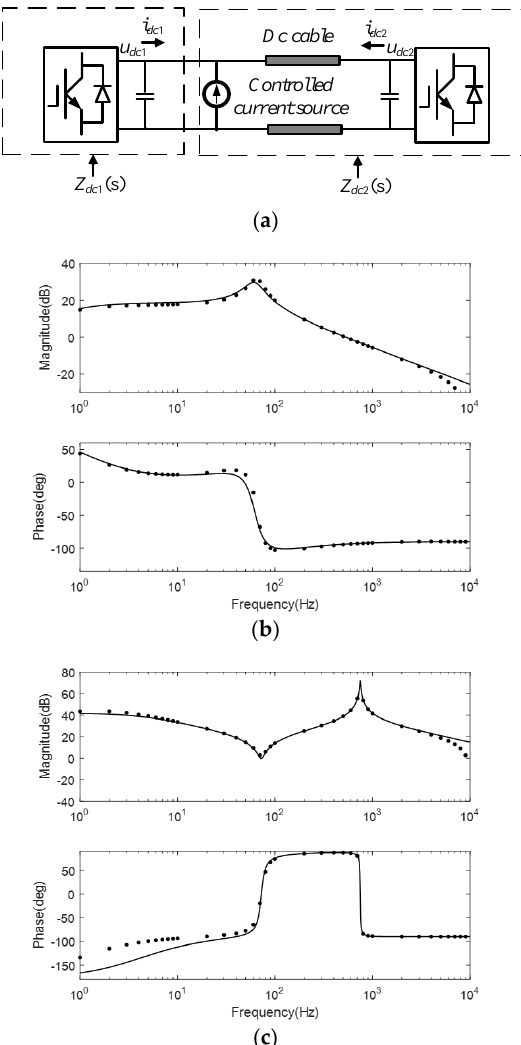
Figure 6. Frequency response of the impedance and verification. The solid line represents the model prediction, and the black points denote the simulation. ( a ) Disturbance signal testing. ( b ) Impedance of the DC voltage-controlled converter ( c ). Impedance of the power-controlled